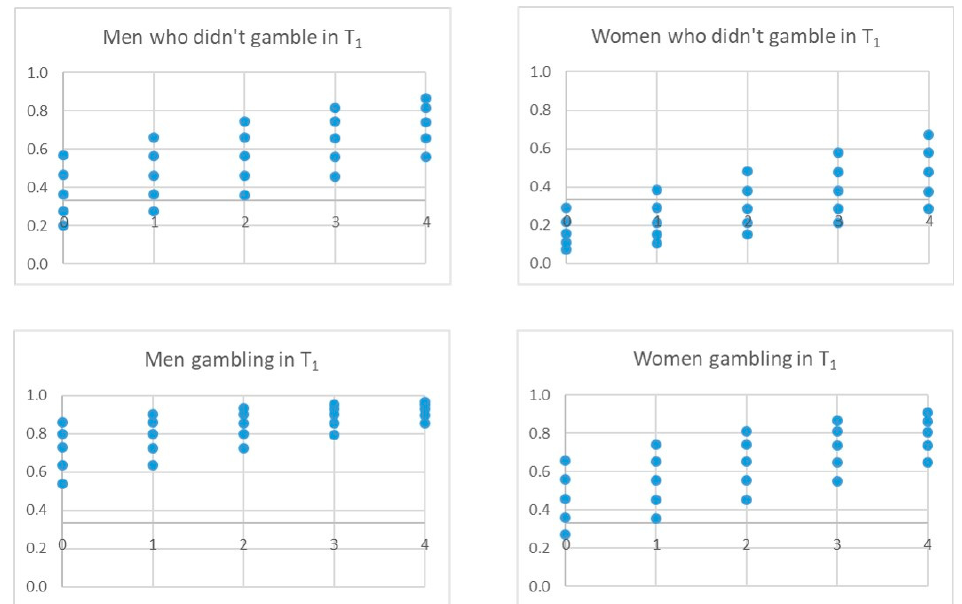
Figure 8. Possible scenarios for model B. Note The X-axis represents the values of the variable risk perception (0, 4). The dots represent the score on the Peer pressure (friends) variable. The horizontal line represents the threshold for a person to be classified as a gambler or not at T 2 . Figure 9 represents the possible scenarios for model C. For example, the accessibility variable seems to have a greater effect on those who have not gambled in T 1 , both for girls and boys, and little effect on those who have already gambled in T 1 .